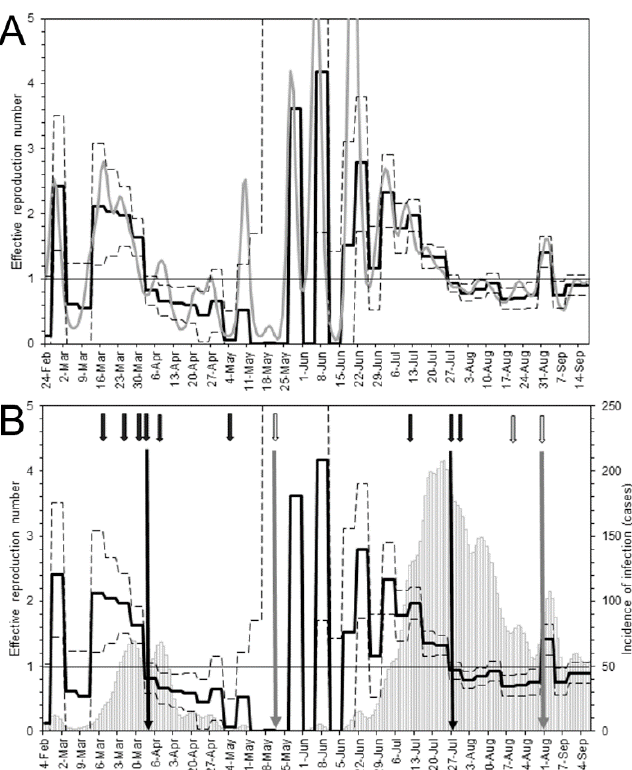
Figure 3. Estimation of the effective reproduction number, R ( t ), using two methods. ( A ) Comparison of R ( t ) estimates calculated using a novel method based on the observed date of illness onset (continuous black line) and using the existing method based on non-parametrically back-projected incidence of infection. Dashed lines show the 95% confidence intervals of R ( t ) based on the bootstrap method. The horizontal gray line indicates R ( t ) = 1; below this value incidence declines. ( B ) Chronological relationship between announcements in Osaka and R ( t ). Black arrows represent announcements of requests to reduce contacts or any other announcements associated with infection control. White arrows represent announcements of the cessation of specific countermeasures. Long black line shows when R ( t ) decline below 1, and long grey arrows indicate when reopening was declared. On 3 April, the governor requested voluntary restrictions on weekend outings. On 28 July, the governor requested residents to voluntarily abstain from social events involving the consumption of alcohol by five or more persons. On 21 May, Osaka was released from the state of emergency, and on 31 August, the governor permitted social events involving the consumption of alcohol by five or more persons. The overlaid bar chart shows incidence by the estimated date of infection.